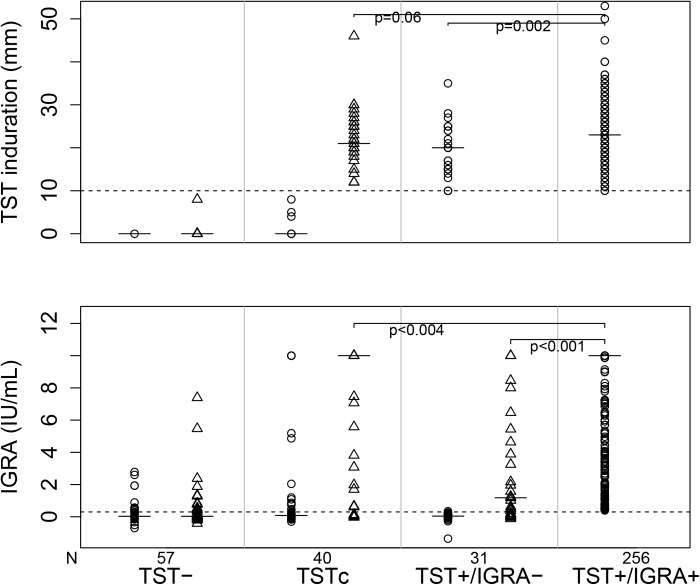
Quantitative analysis of tuberculin skin test (TST) and interferon gamma release assay (IGRA) results among four groups of contacts exposed to a patient with pulmonary tuberculosis: 1) TST- = contacts who have TST<10mm at baseline and 6 weeks; 2) TSTc = contacts who undergo TST conversion at 6 weeks (see definition in Methods); 3) TST+/IGRA- = contacts with TST ≥10mm at baseline and IGRA-; and 4) TST+/IGRA+ = contacts with TST ≥10mm at baseline and IGRA+.Circles indicate baseline values and triangles indicate values at 6 weeks. The solid horizontal bars indicate the median value. The N for each group is the same for TST and IGRA results.